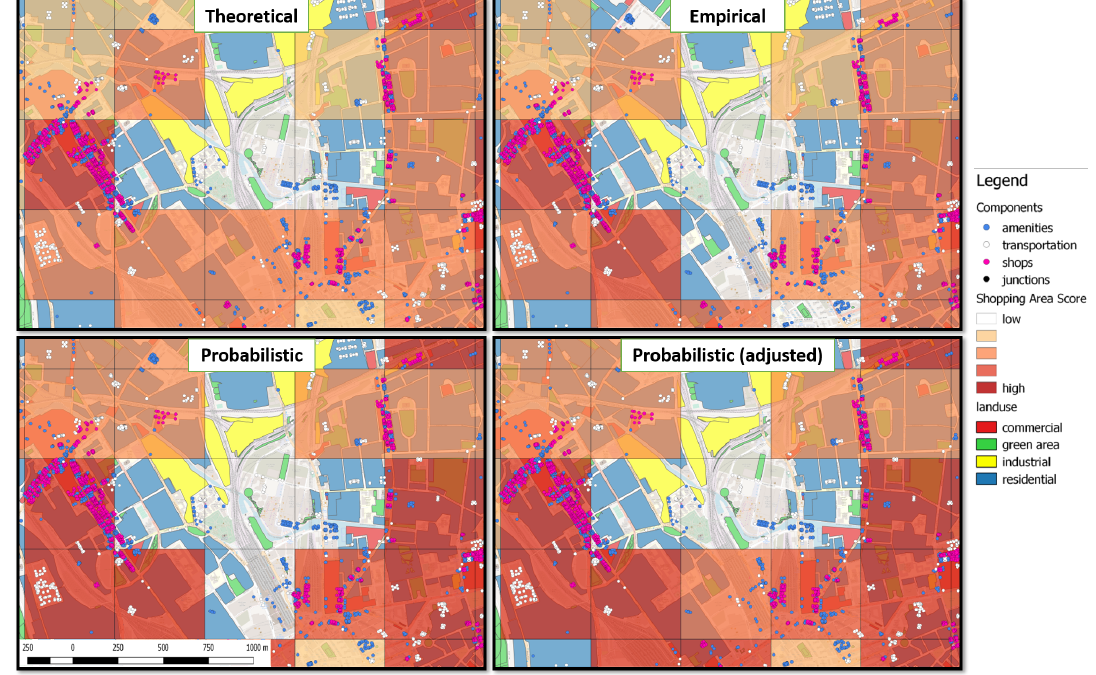
Figure 9. Evaluation of results against stated land use in